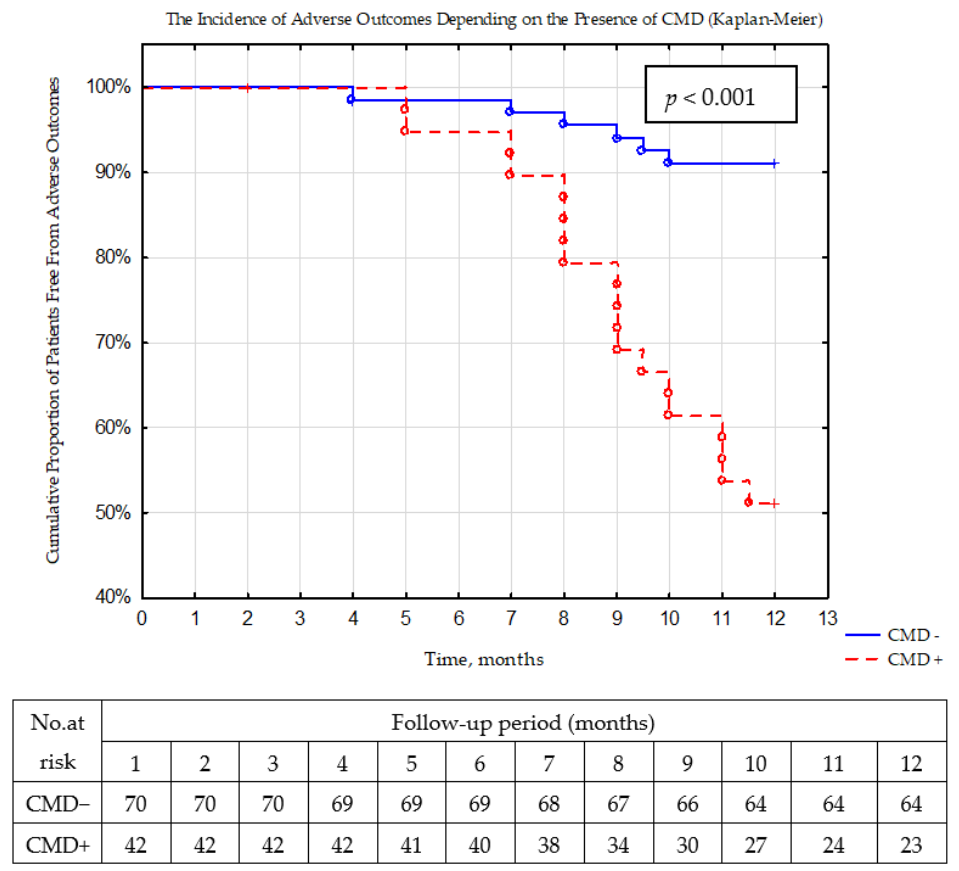
Figure 2. The rate of adverse outcomes during 12 months of follow-up period depending on the presence of coronary microvascular dysfunction (Kaplan–Meier).